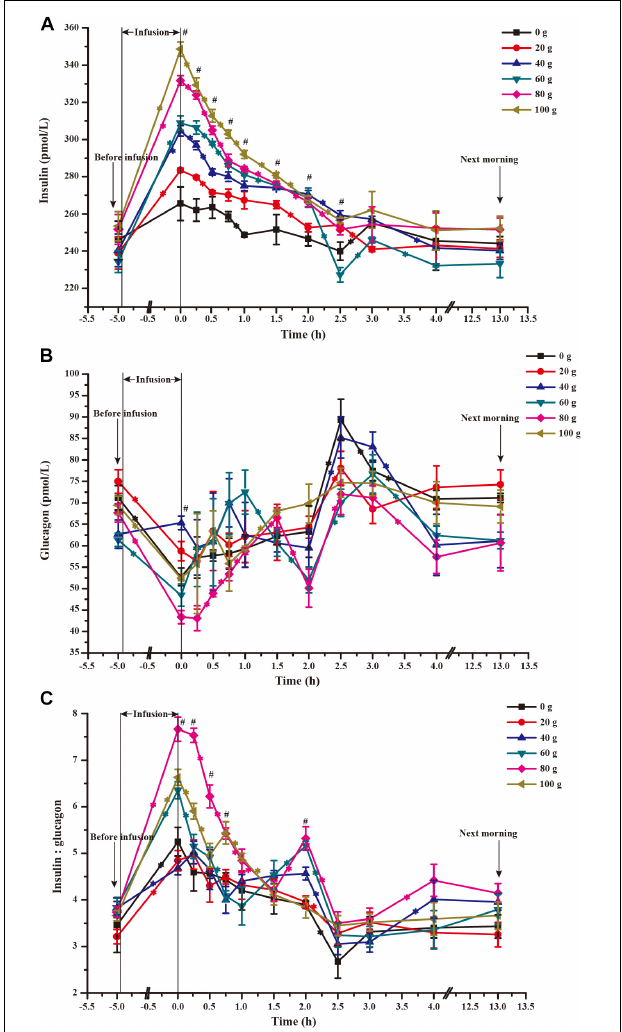
FIGURE 7 | Time-course of artery insulin (A) and glucagon (B) and their ratio (C) when 0–100 g/d of glucose was infused to the mammary gland. The 0 time in the X axis represents the end time of infusion. “ ∗ ” represents significant difference in time effect of each group, and “ # ” represents significant difference in treatment effect at individual time points ( P <